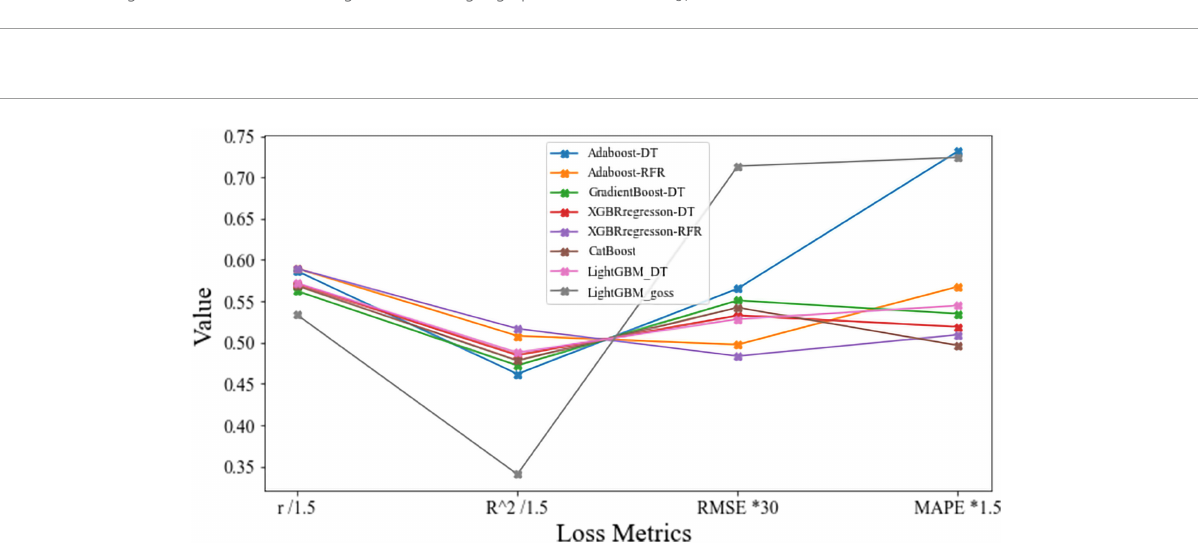
FIGURE4 Model comparison of eight boosting algorithms with four loss metrics. “Adaboost-DT” and “Adaboost-RFR” are Adaboost algorithms with the decision tree and the random forest classifier. “XGBoost-DT” and “XGBoost-RFR” are XGBoost algorithms with the decision tree and the random forest classifier. “LightGBM-DT” and “LightGBM-goss” are light gradient boosting algorithms with the decision tree classifier and goss algorithm. “GBM” is the gradient boost algorithm with the decision